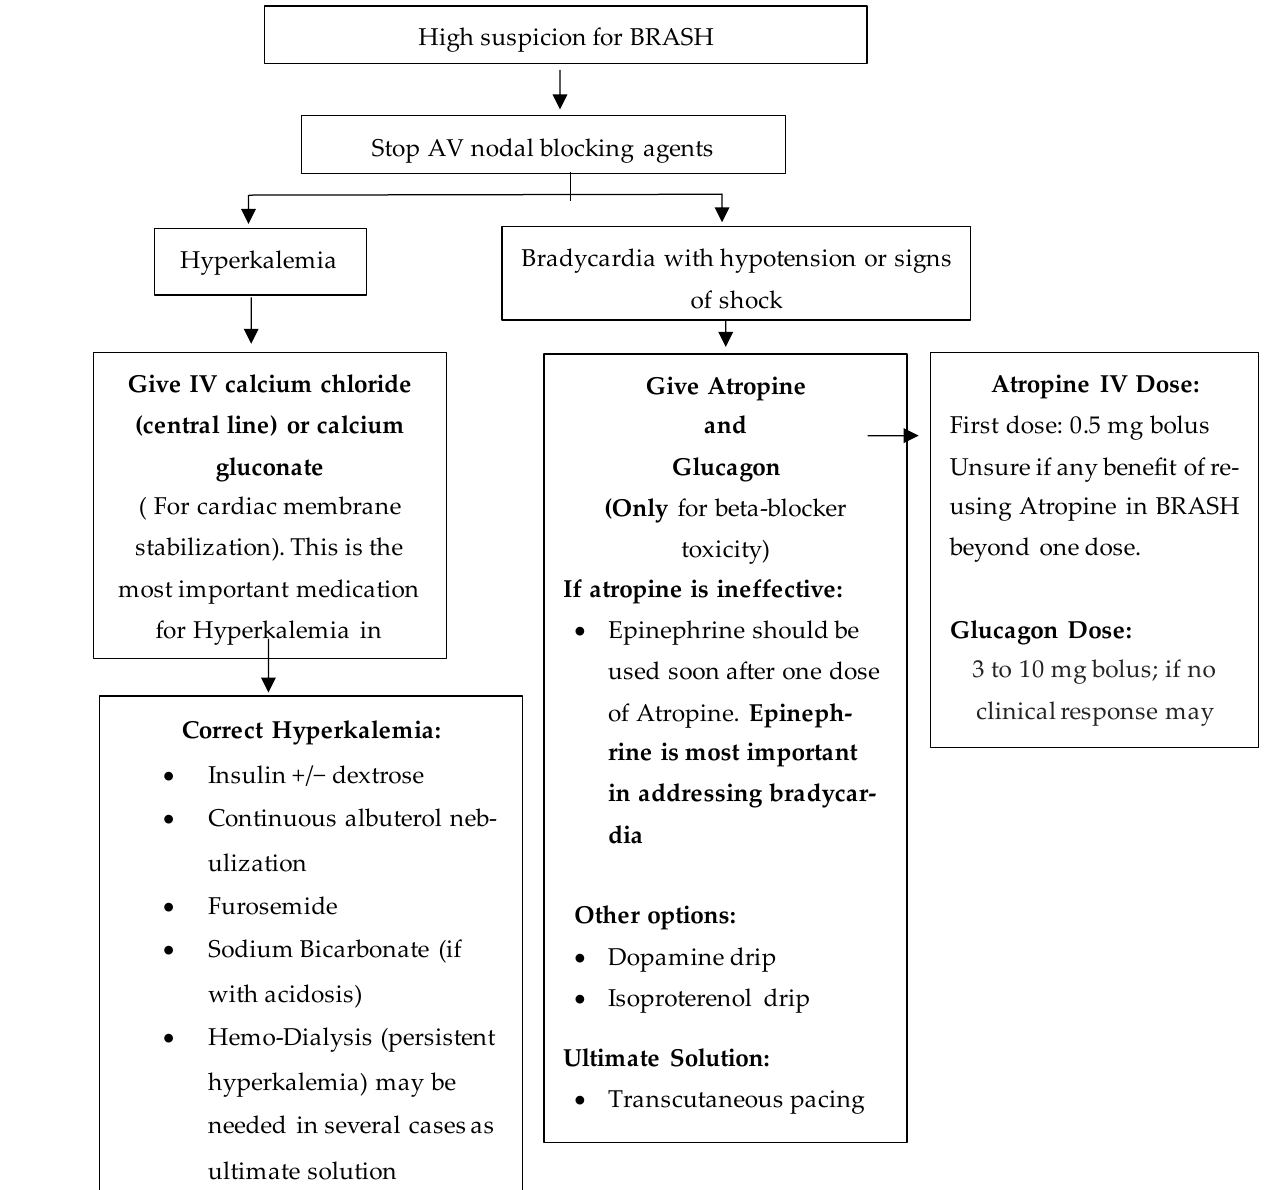
Figure 2. BRASH management algorithm.